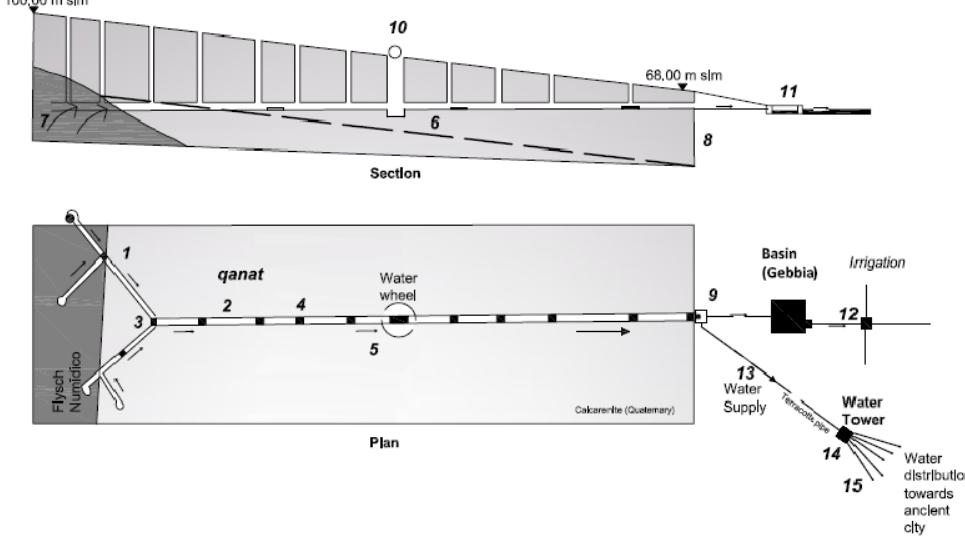
Figure 5. Hydrogeological model of Gesuitico Alto qan ā t : 1, main and secondary drainage tunnels; 2, collector channel; 3, mother well; 4, vertical shafts; 5, flow direction; 6, water table level in the limestone formation; 7, substrate supply; 8, qan ā t mounth; 9, collecting tank; 10, senia ; 11, irrigation tank ( gebbia ); 12, irrigation chanals ( saje ); 13,